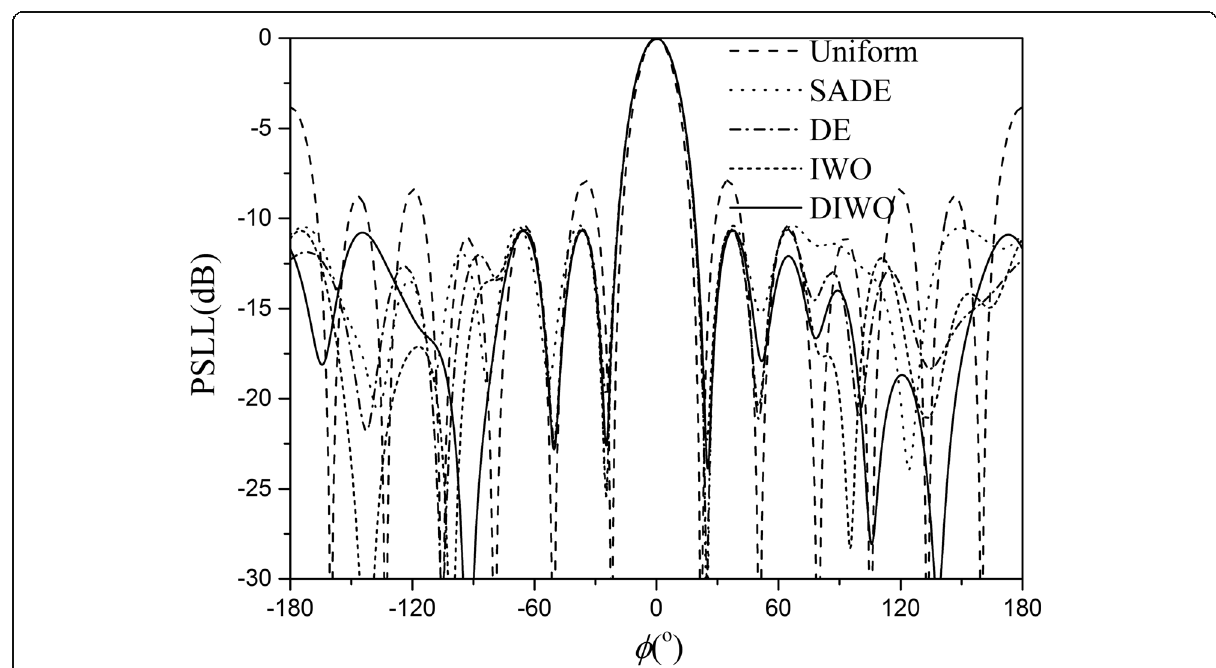
Fig. 5 Radiation pattern of elliptical antenna array with 12